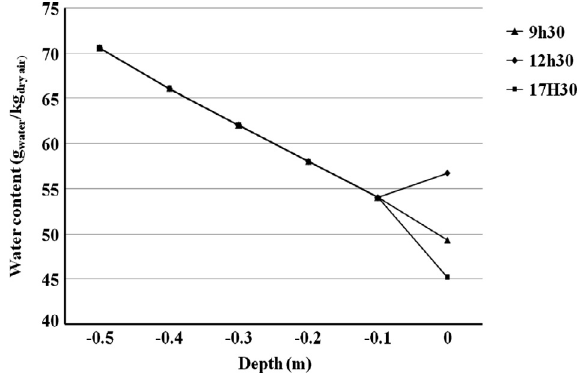
Figure 10. Temperature evolution in terms of depth (May 15).